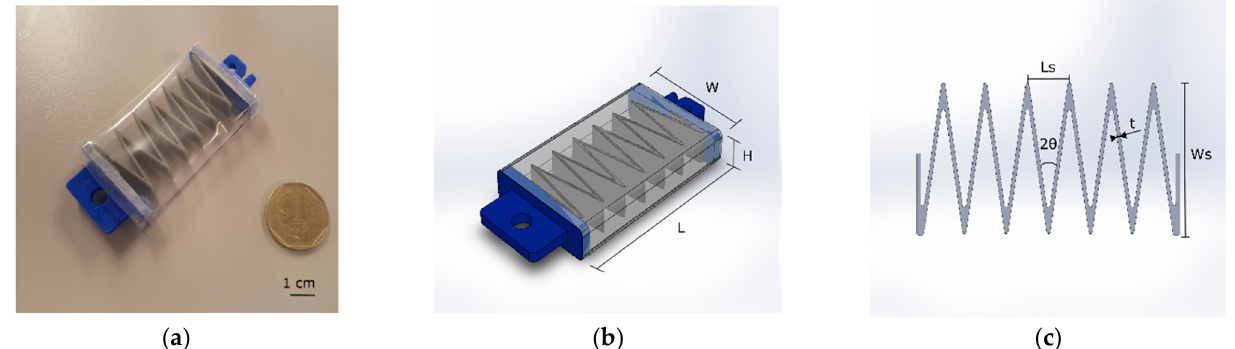
Figure 2. Image of assembled actuator with reference scale ( a ) and labels of geometrical parameters of actuator ( b ) and zigzag skeleton ( c ).